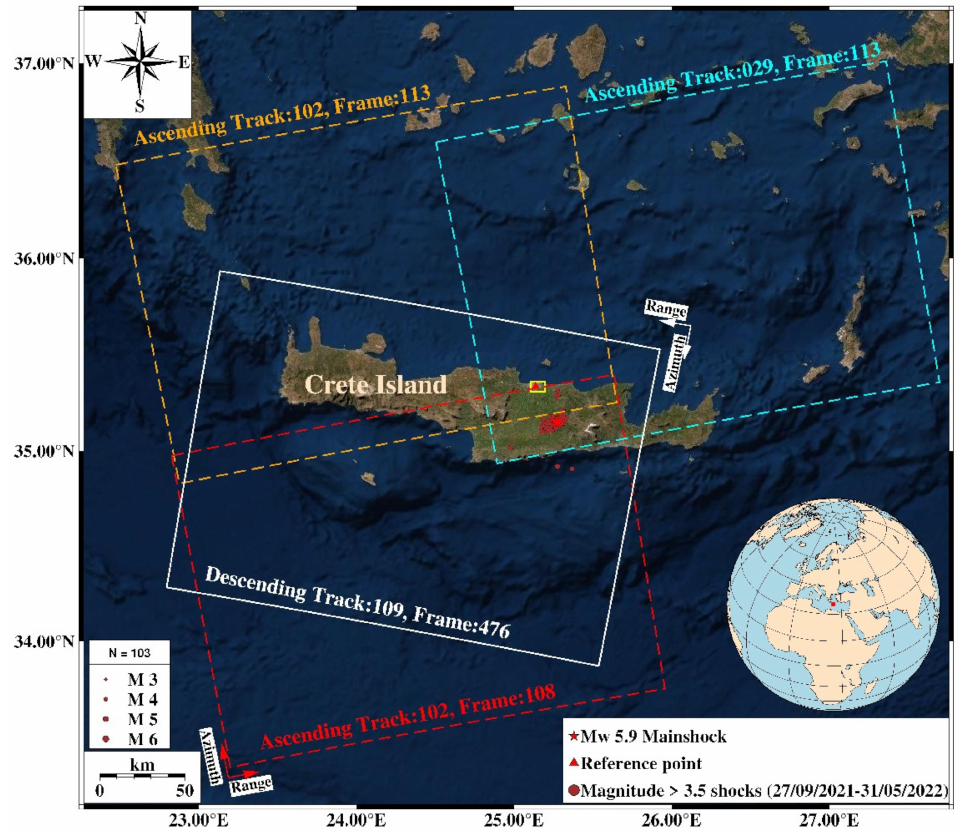
Figure 1. Study area. Red star represents the epicenter of the 2021 Mw 5.9 Arkalochori earthquake; red triangle marks the location of the reference point; yellow rectangular means the area of the city of Heraklion. Brown dots represents the shocks with a magnitude larger than 3.5 after the Mw 5.9